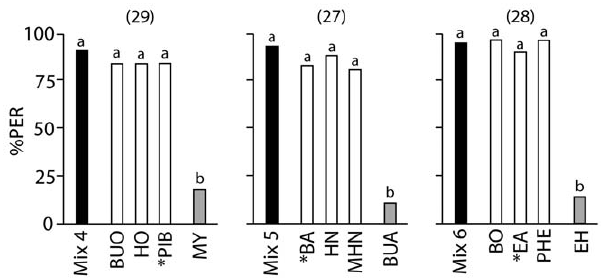
Figure 3. Effect of Odorant Uniqueness on Key Odorant Signatures. The ordinate represents the percentage of proboscis extensions (PER) to the training mixture (black bars), to the individual test odorants that the mixture was composed of (white bars), and to a control odorant that was not part of the training mixture (grey bars). Each mixture was composed of two odorants with the same functional group and one unique odorant with a different functional group, indicated by *. The control odorant shared the chemical characteristic of the unique odorant. The numbers in brackets indicate the numbers of bees trained and tested in each experiment. Different letters above bars (a or b) indicate significant differences between PER to the training mixture and to the individual odorants (McNemar test [2 6 2 Table], Bonferroni corrected threshold p , 0.0125). Bees responded to the individual odorants of a mixture as well as to the training mixture, but responded significantly less to the control odorant. (Left) Bees were trained to mixture 4; (Centre) bees were trained to mixture 5; (Right) bees were trained to mixture 6. For mixture compositions see Table 6. Odorants are listed alphabetically by their abbreviations; for corre- sponding odorant names, see Table 1. Q = 51.9, p , 0.001), and when trained with mixture 9, they responded well only to b -pinene when compared to the training mixture (Fig. 4C; McNemar test [2 6 2 Table] with Bonferroni corrected threshold; Chi square =0; df= 1; p = 1.0; preceding Cochran’s Q Test, Q =52.2, p , 0.001), but again this effect only